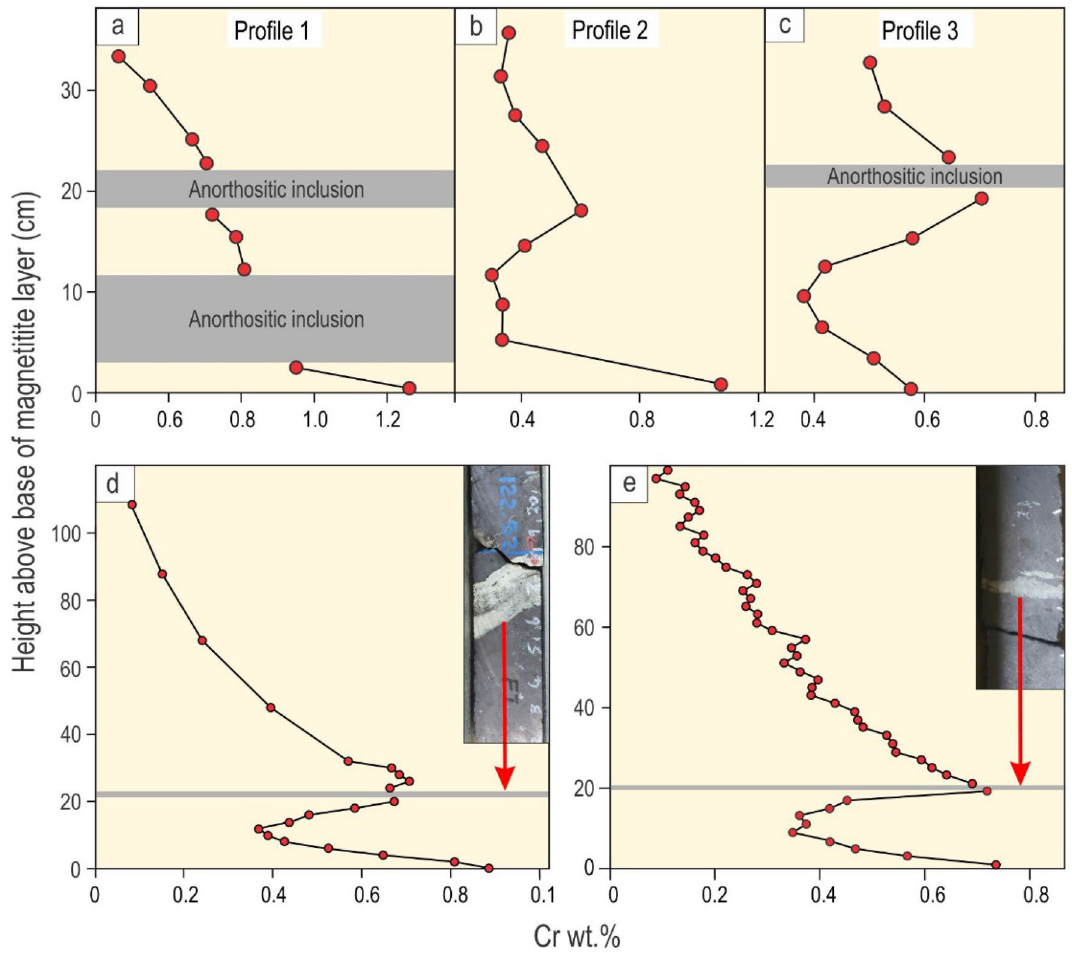
Figure 3. One-dimensional vertical profiles in Cr content across a massive magnetitite. Position of these three profiles across the bottom seam of massive magnetitite is indicated on Fig. 1b. (a) A rapid continuous decrease in Cr content upwards with no chemical changes/breaks at anorthositic inclusions; (b) A gradual reversal in Cr content in a level where no anorthositic inclusions are visible; (c) An initially rapid decrease in Cr content followed by its gradual increase towards an anorthositic inclusion. Cr content again declines upwards from the top of the anorthositic inclusion. (d) and (e) Additional examples of vertical profiles in Cr content across the bottom seam that contains anorthosite inclusions from drill cores in a different locality (Vametco mine, Western Bushveld Complex). Insets show anorthositic inclusions (light in colour) trapped within the massive magnetitite (dark in colour). The distribution of the Cr in these two examples is similar to that in (c) . Vertical geochemical profiles are analysed using a handheld X-ray fluorescence spectrometer (pXRF). The pXRF data for Fig. 3a–c can be found in Supplementary Information Table 1, for Fig. 3 d in Supplementary Information Table 2 and Fig. 3e in Supplementary Information Table 3. Geochemical profiles are prepared using Microsoft Excel